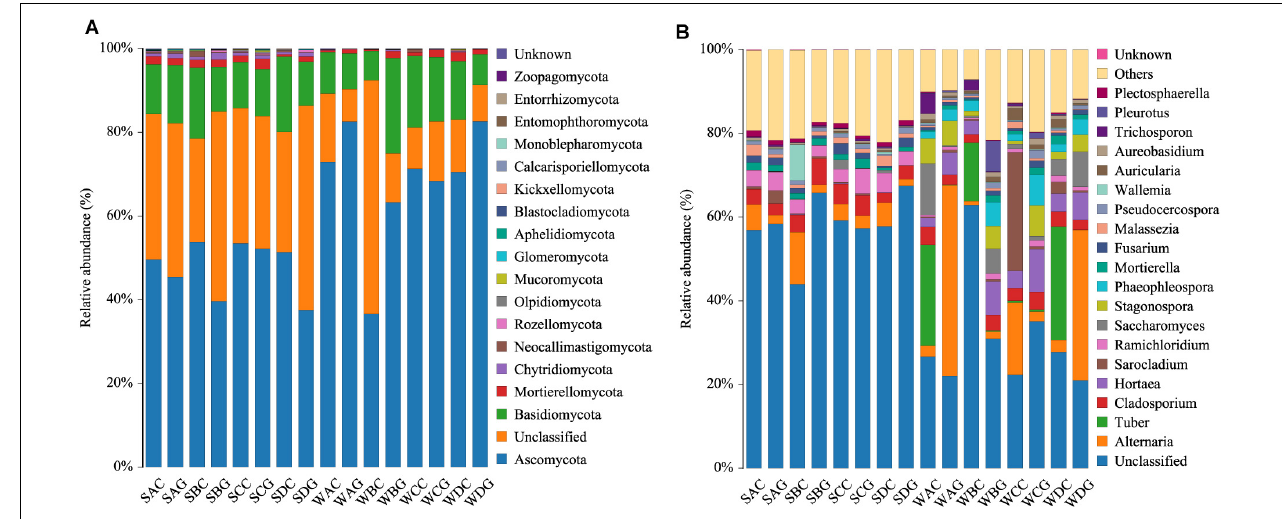
FIGURE 1 | Species distribution of each group in 50 shrimps. Panel (A) at the phylum level; panel (B) at the genus level (top 20=). The sample ID referred to Table 1 .